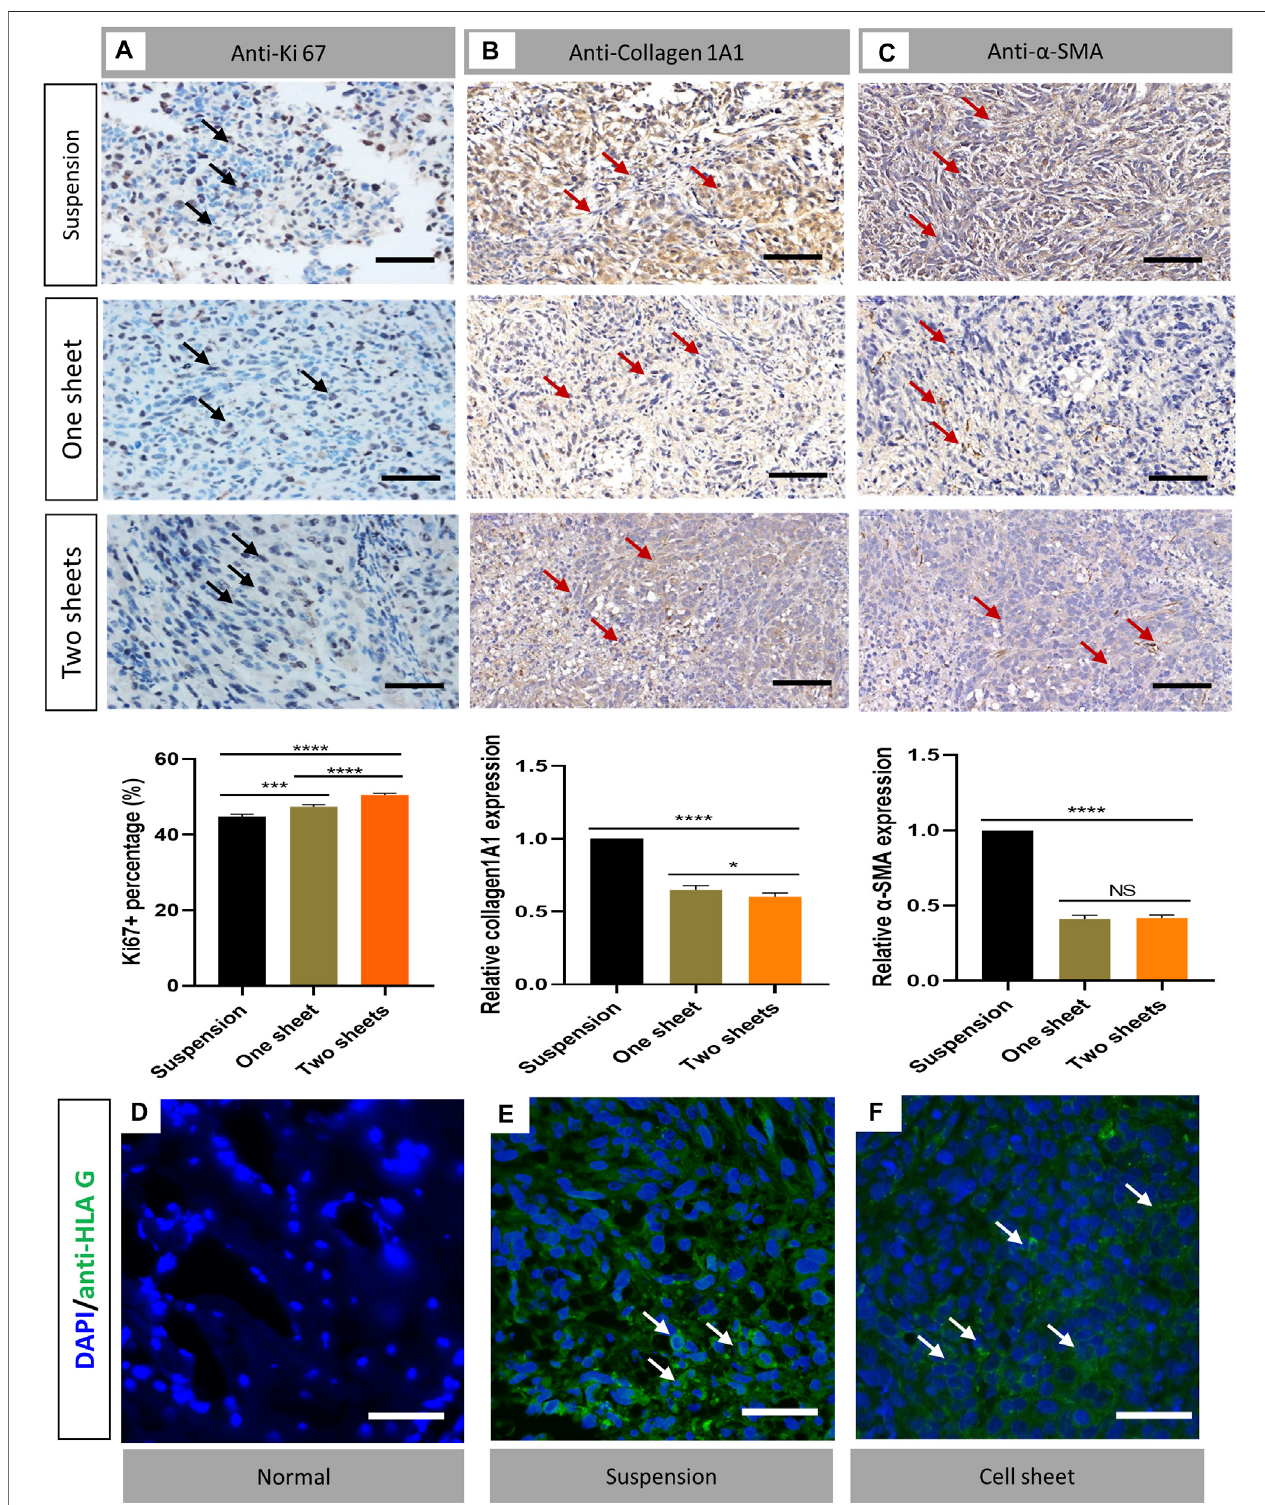
FIGURE4 | Immunostaininganalysis ofcell proliferation and detection of fi broblasts and cell origin. (A) Ki67stainingresults oftransversesections oftumor in each group. (B) Collagen1A1stainingofrepresentative samplefromeach group (C) . α -SMAstainingofrepresentativesamplefrom eachgroup(n (cid:2) 6). Statisticalsigni fi cance was calculated by Student ’ s t test. ns p > 0.05, * p < 0.05, *** p < 0.001, **** p < 0.0001. Scale bar (cid:2) 200 μ m (D – F) Immuno fl uorescent staining of anti-HLA G (green) in normal bone, cell suspension – induced tumor and cell sheet – induced tumor samples, respectively. Scale bar (cid:2) 50 μ m.